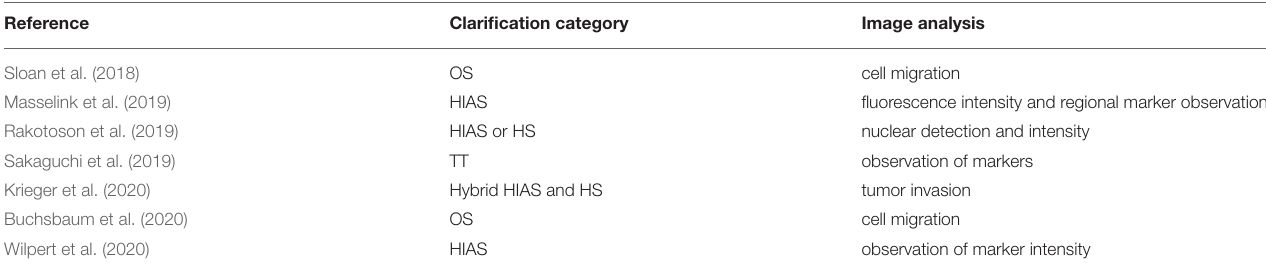
TABLE 3 | References of articles using clarification on 3D brain cultures and corresponding image analysis between January 2018 and June 2020.